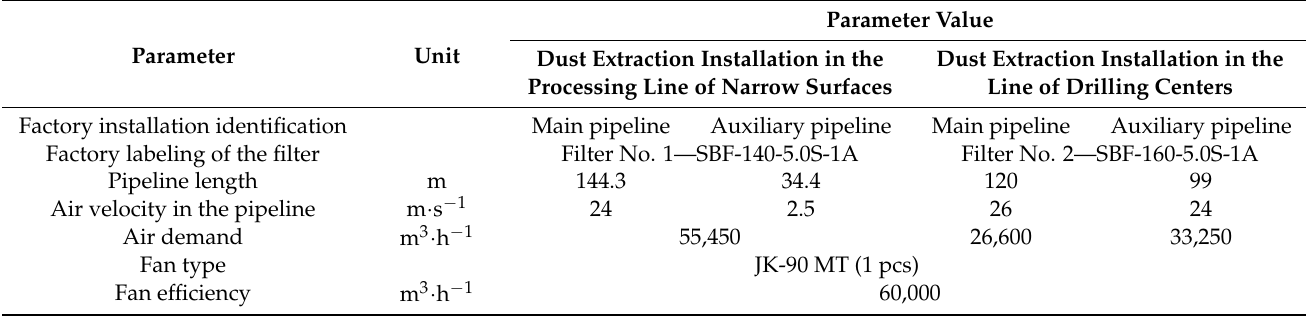
Table 1. Basic technical parameters of filtration